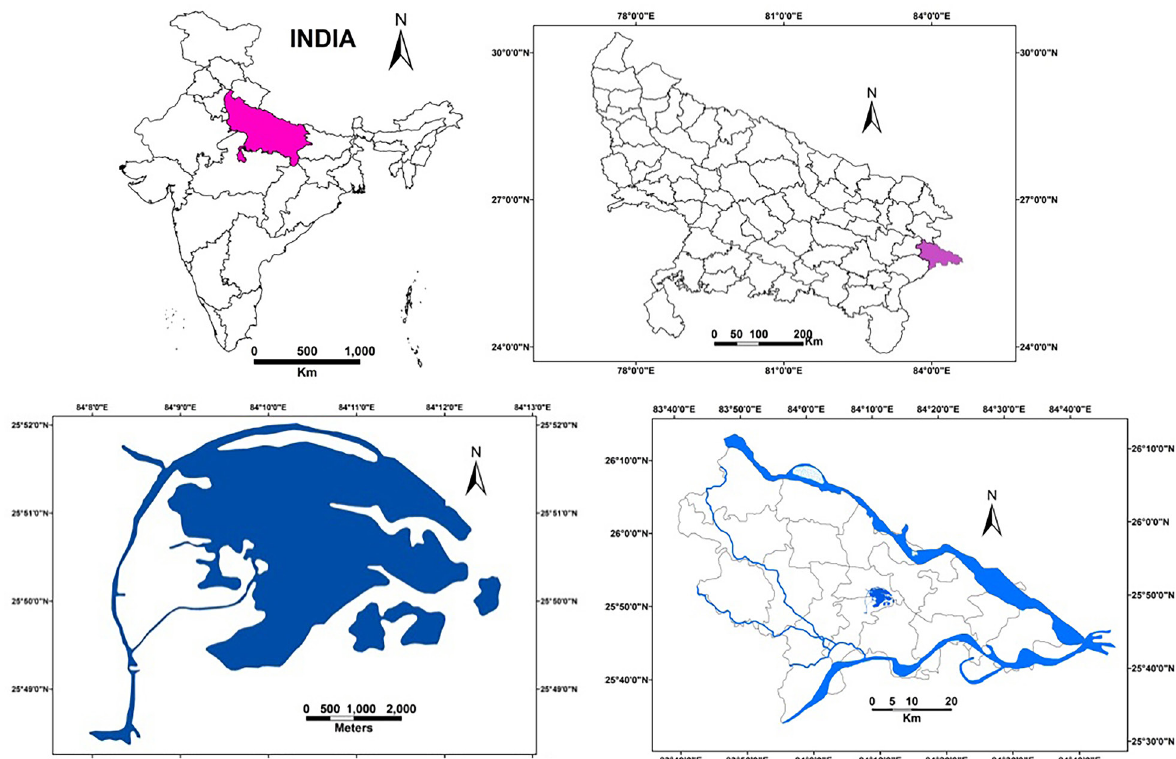
Fig. 1. location of Suraha Tal Wetland in Uttar Pradesh, India. Source: own